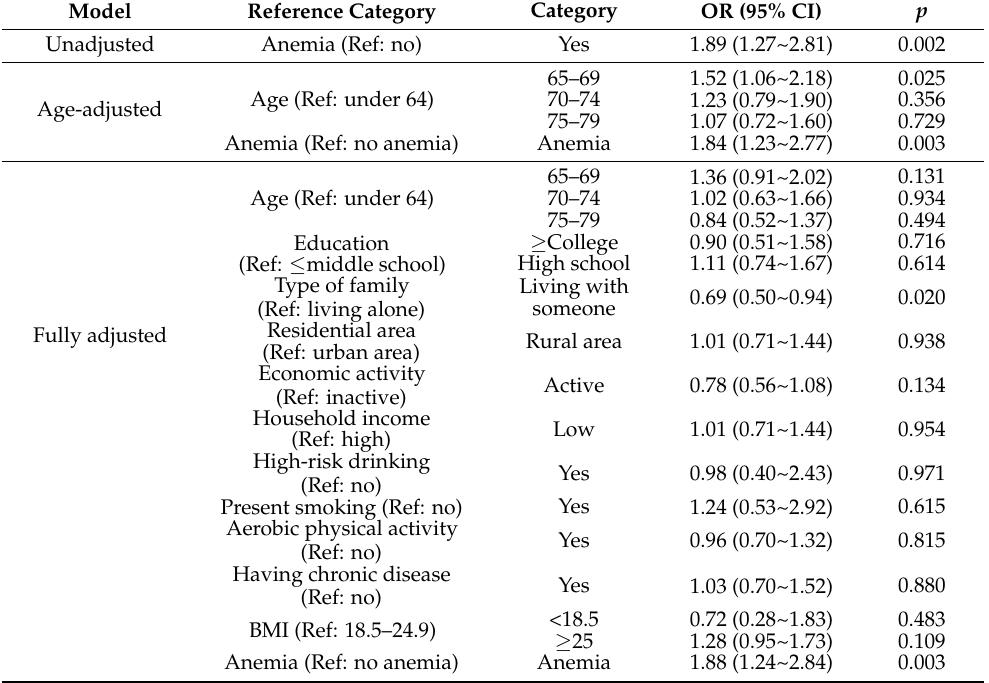
Table 4. Factors related to fall